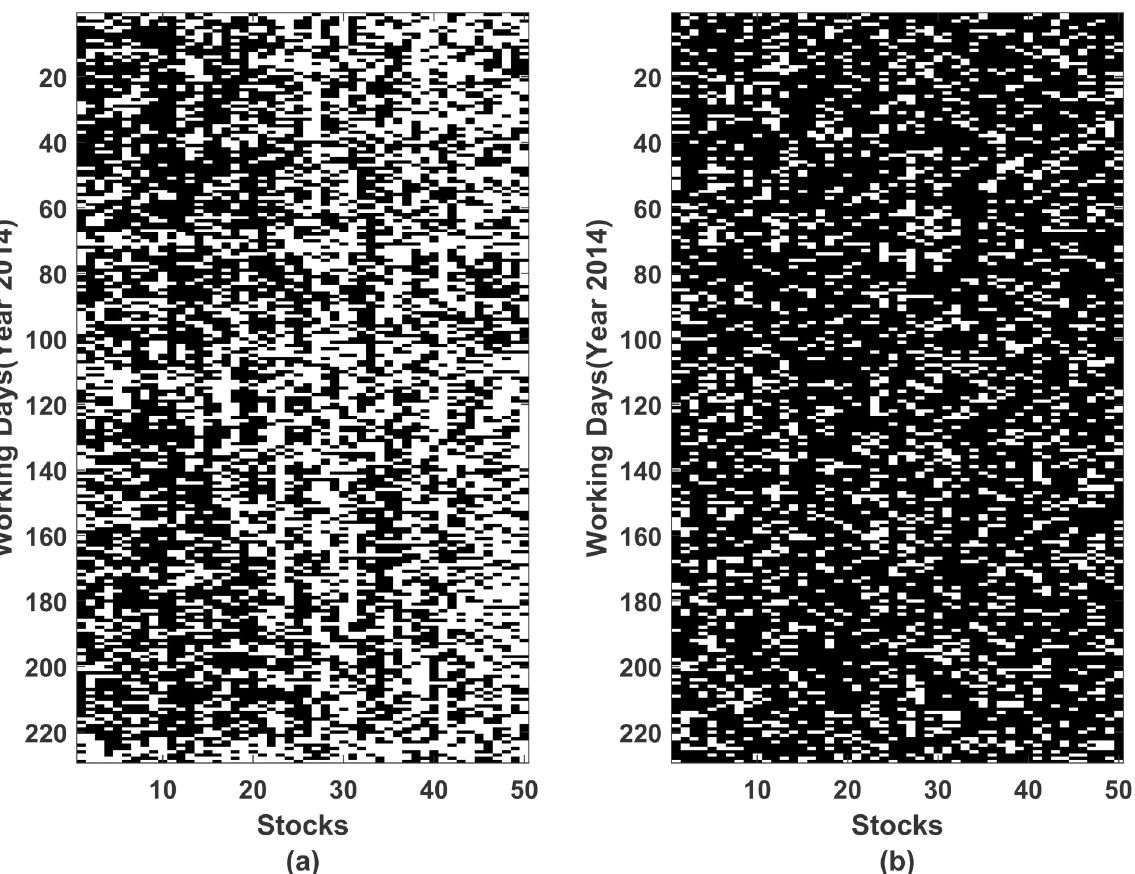
Fig 2. Ljung-Box test on log returns and squares of log returns. On horizontal axis we have listed 50 stocks and on vertical axis we have working days of year 2014. Black and white colour represents that the null hypothesis ( H 0 : data is independent , H A : data exhibit serial correlation ) is rejected or accepted respectively. (a) Corresponds to test applied to log returns (b) Corresponds to test applied to squares of log returns.